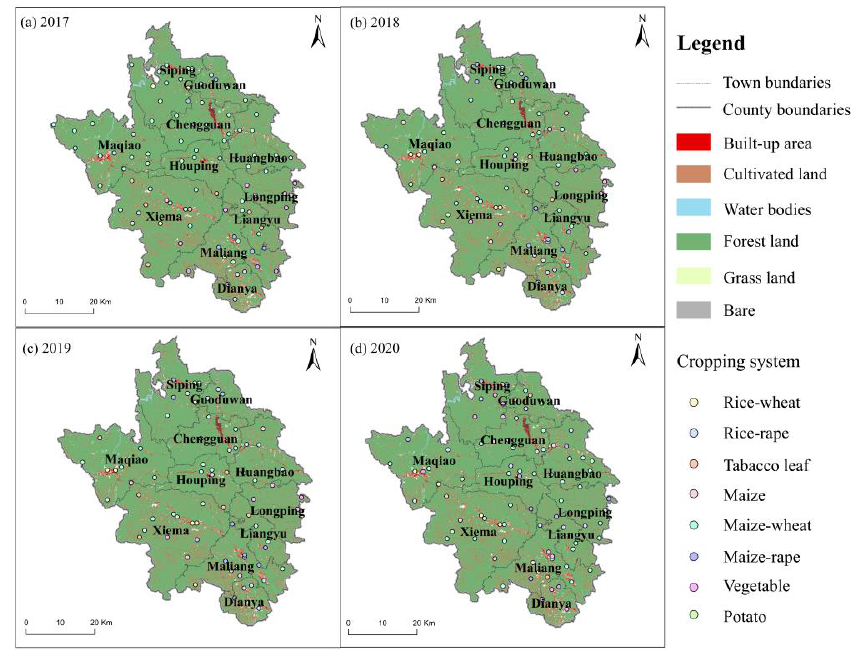
Figure 2. Location, elevation, and soil sample location in Baokang County.